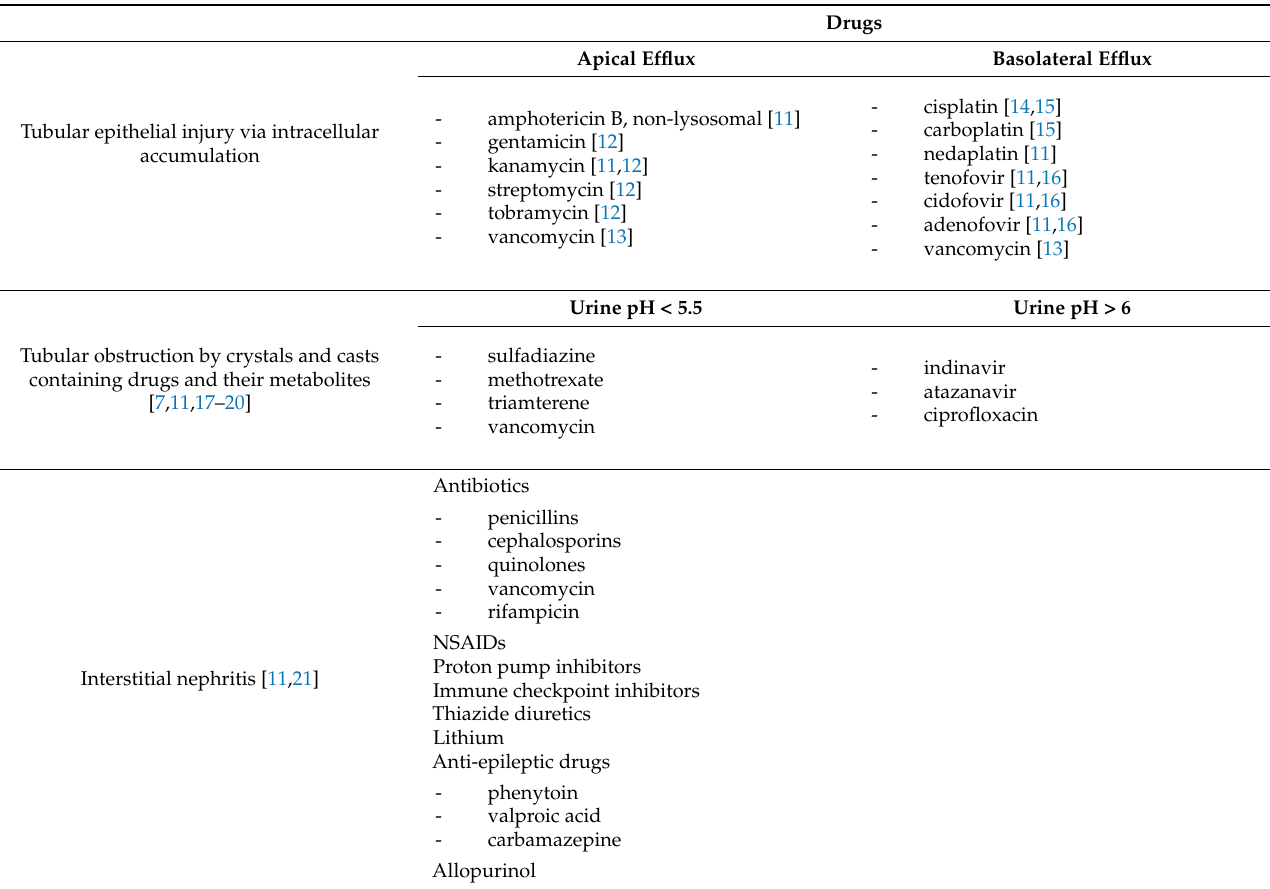
Table 1. The types of kidney injury, together with the ascribed drugs that trigger